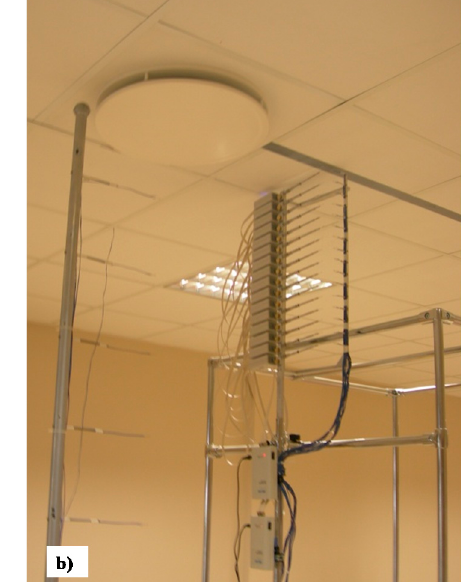
Figure 5. Experimental rig for testing RWJs. ( a ) Schematic of the rig; ( b ) thermo-anemometric transducers with spherical sensors and thermocouple sensors installed on a stand with a traversing mechanism.